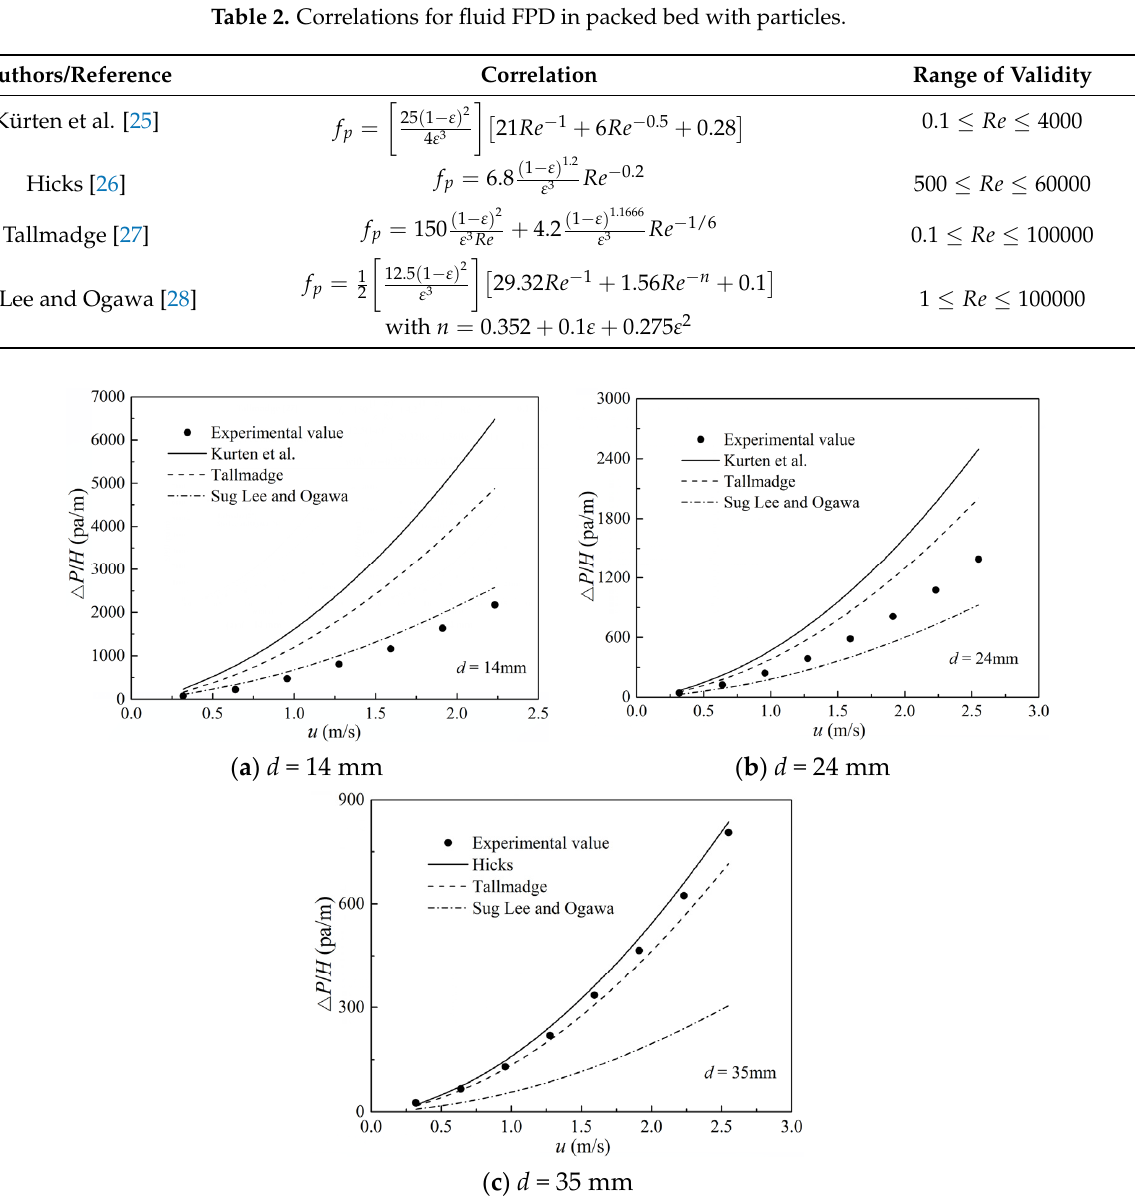
Figure 5. Comparisons of calculation and experimental values for different particle diameters.